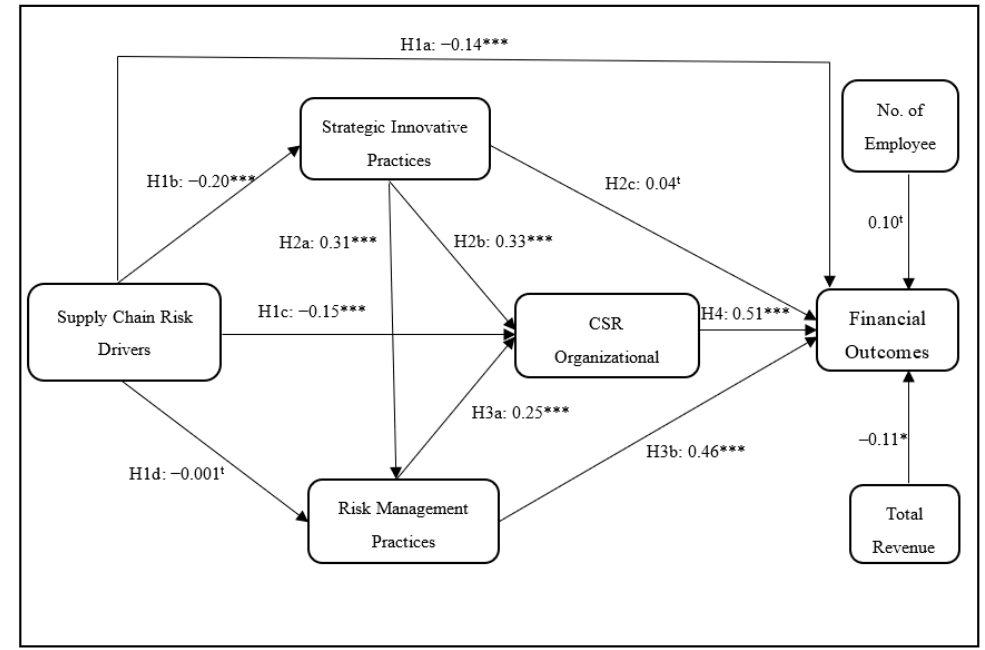
Table 3. Structural Model Results. Figure 3. Analysis of Empirical Results. Notes: * 90% significance level; *** 99% significance level; t: statistically insignificant.